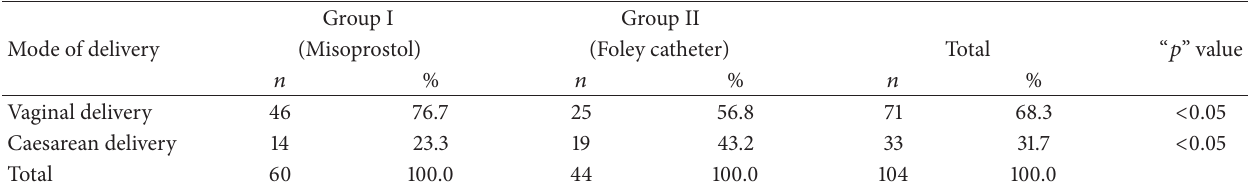
Table 4: Comparison of mode of delivery.